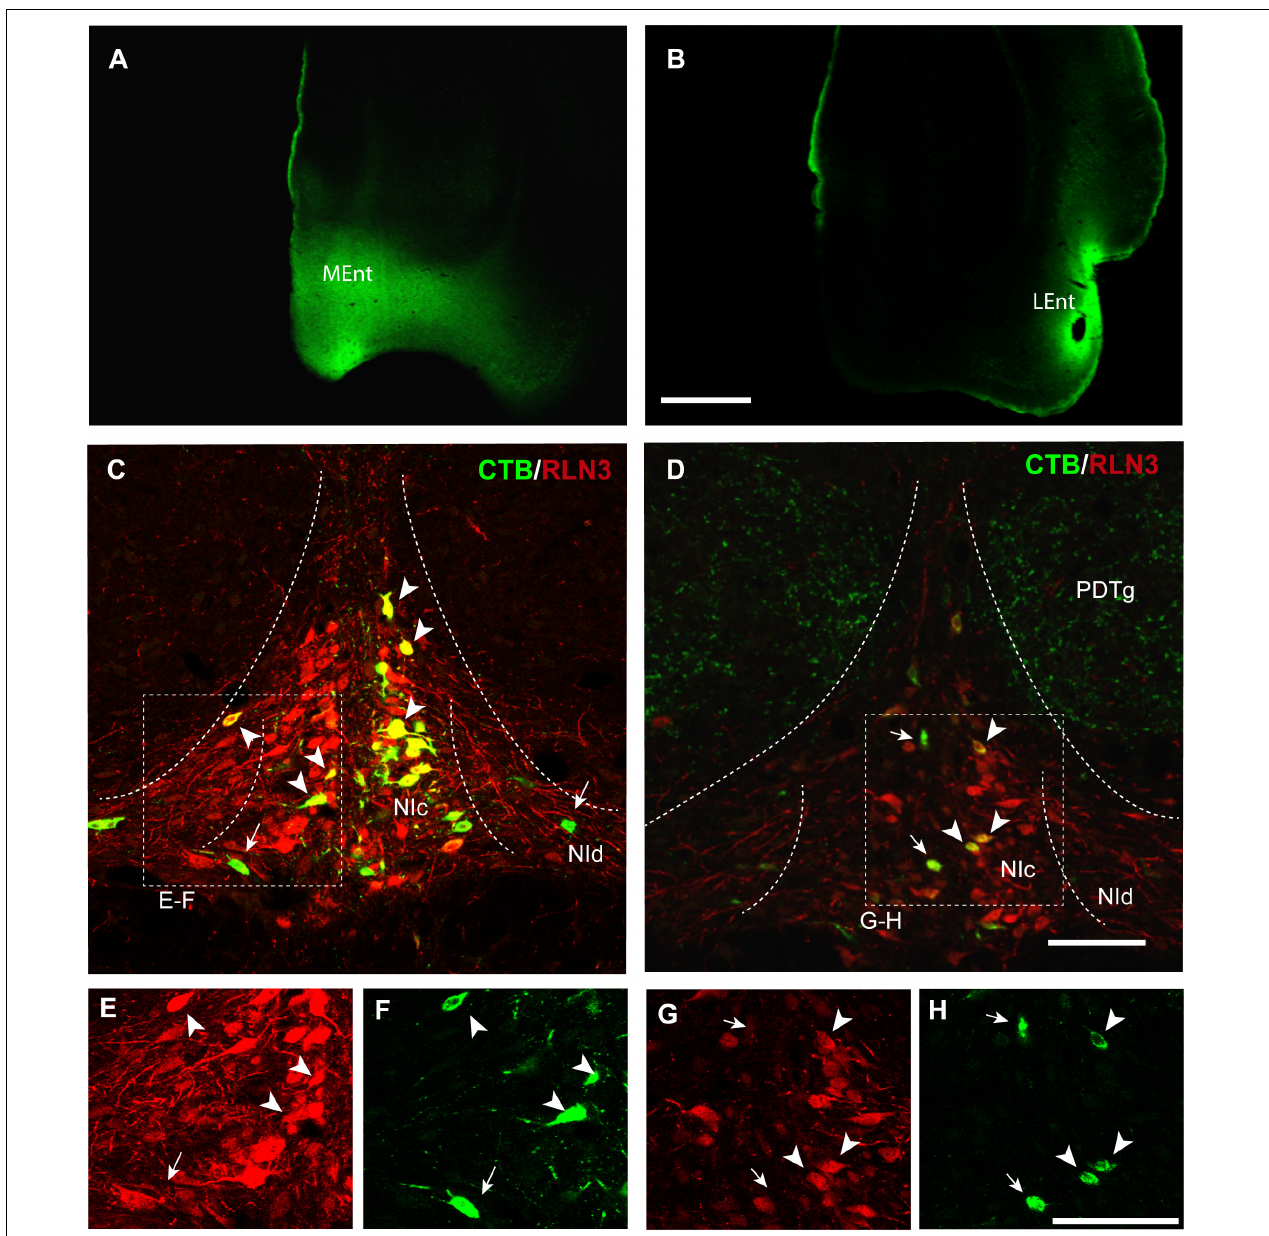
FIGURE 2 | Retrograde labeling of RLN3 neurons in the NI that project to the parahippocampal cortex. This projection is essentially ipsilateral, but some labeling was also observed on the contralateral side. (A) CTB injection in the MEnt, case MS9. (B) CTB injection in the LEnt, case MS19. Calibration bar 1 mm. (C) Retrograde labeling of neurons in the NI after CTB injection in the MEnt with RLN3 IF, case MS9. (D) CTB injection into the LEnt resulted in retrograde labeling of NI neurons, most of which displayed RLN3 IF, case MS19. Arrows point to single CTB retrogradely labeled neurons, arrowheads point to double-labeled CTB and RLN3 neurons. (E,F) Separated channels for RLN3 and CTB of the square in (C) . (G,H) Separated channels for RLN3 and CTB of the square in (D) . Calibration bar 100 µ